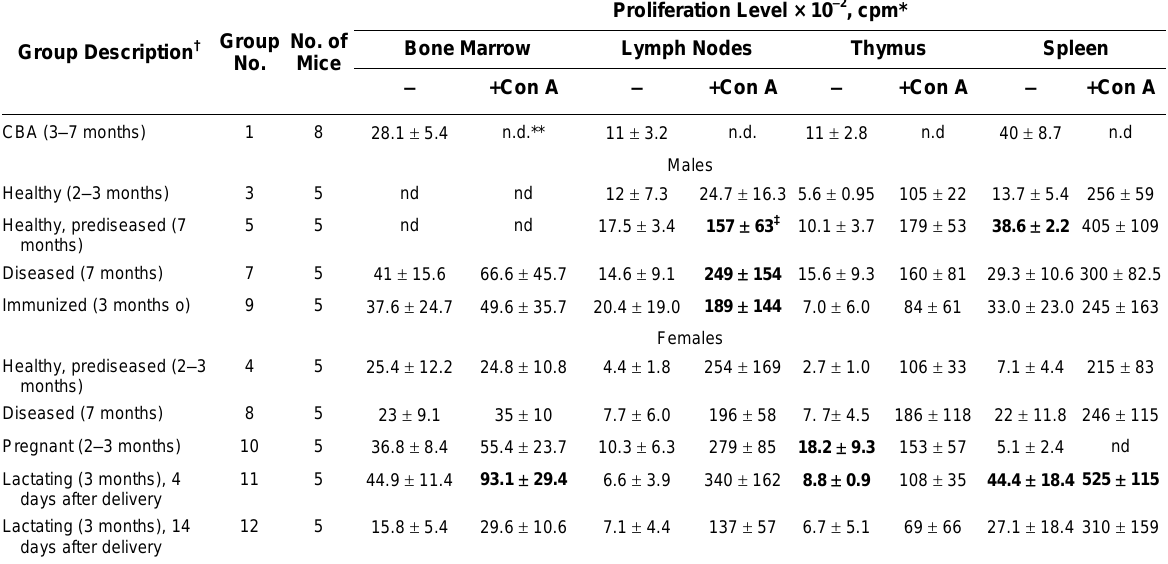
Lymphocyte Proliferation in Mouse